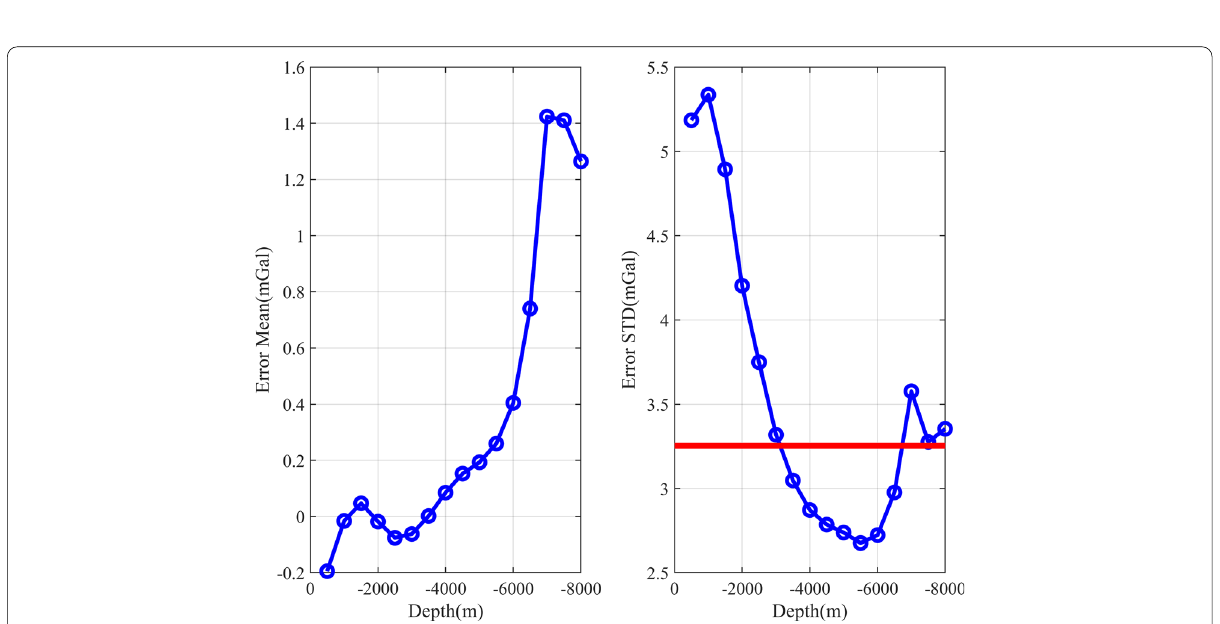
Fig. 4 Error distribution of GMGA1